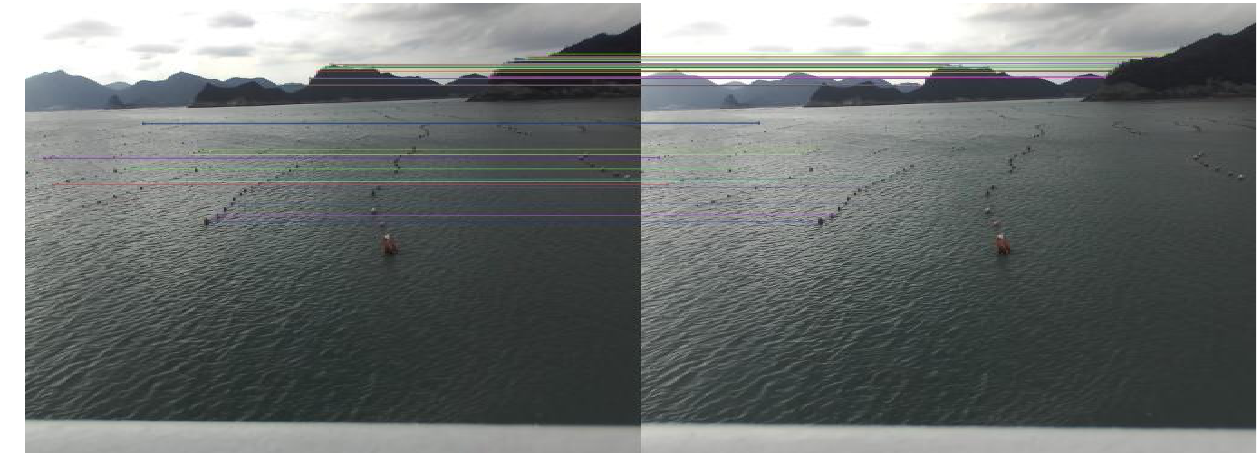
Figure 20. Key point matching by ORB (Experiment B).